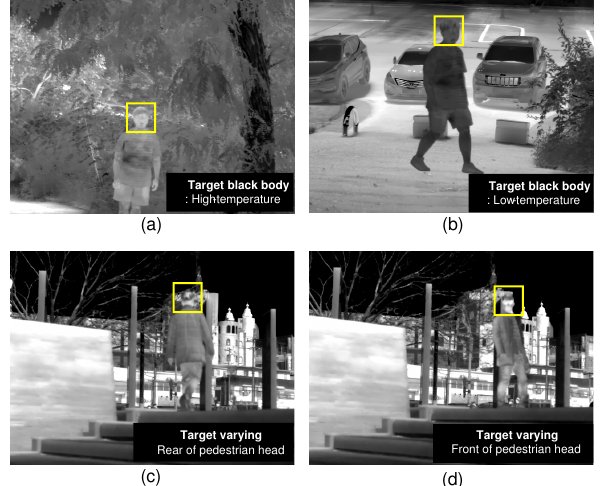
Figure 1. Change in the target brightness due to background temperature change.